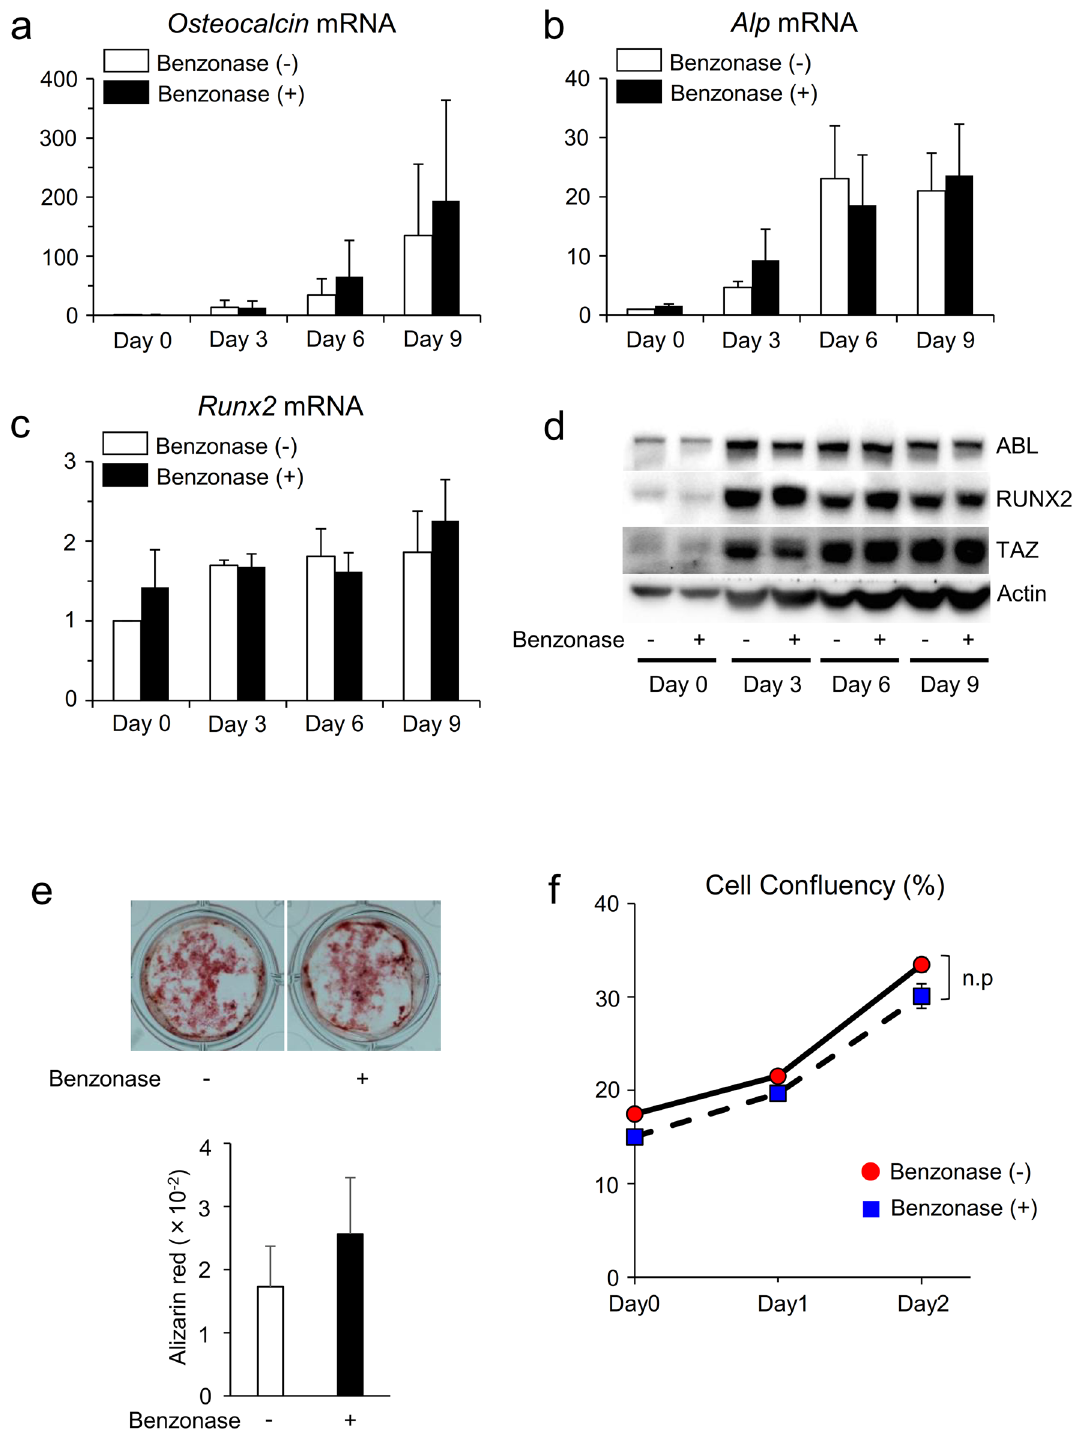
Figure 3. Benzonase did not affect osteoblast differentiation and proliferation. ( a – c ) qPCR analysis of Osteocalcin ( a ), Alp ( b ) and Runx2 ( c ) mRNA expression in primary murine osteoblasts expanded and collected in Fig. 1d and cultured in an osteogenic medium for 3–9 days. n = 3. ( d ) Whole cell lysates from cells in ( a – c ) were probed with the indicated antibodies for Western blot analysis. ( e ) Primary murine osteoblasts expanded and collected in Fig. 1d were cultured in an osteogenic medium for 21 days and stained with alizarin red S solution (upper). Mineralization of the cells was evaluated by the absorbance at 405 nm (lower). n = 4. ( f ) Growth curves of primary murine osteoblasts expanded and collected in Fig. 1d and cultured in a growth medium for 2 days. P values were determined by the unpaired t-test. Data are presented as means ± SEM. * P <